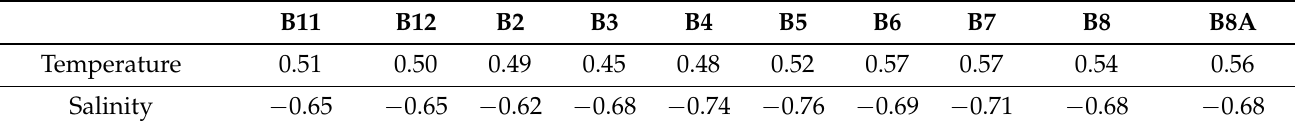
Table 4. Correlation coefficients between temperature, salinity and remote sensing bands.